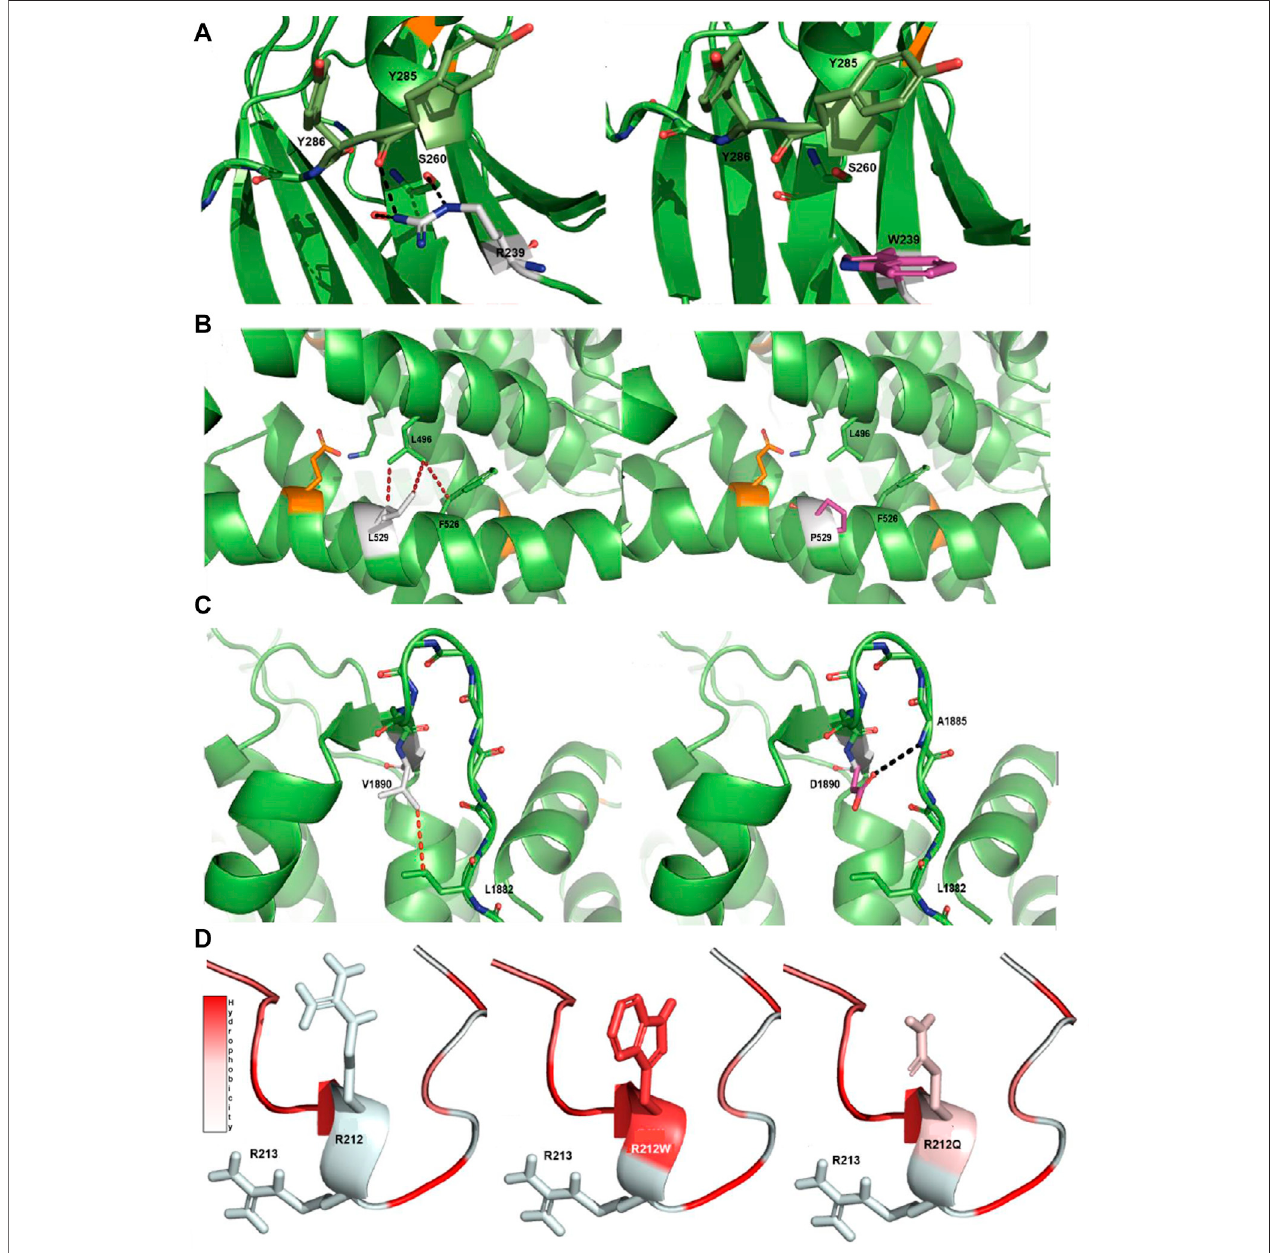
FIGURE2 | Protein modeling of variants with anotable effect on protein structure. (A) R239W VUS-high in PKC γ protein. The native R239interactswith S260and Y285 through a hydrogen bonding network. The aromatic side chain of the mutant W is unable to establish an interaction network in the same manner as the native arginine. (B) L529P VUS-high in Cav2.1 protein. The native L529 engages in a network of hydrophobic interactions with L496 and F526. The introduction of P in the middle of the helix introduces a steric clash with these hydrophobic residues and is detrimental for helix stability (Visiers et al., 2000). (C) V1890D VUS-high in Cav2.1 protein. The native V1890 interacts with L1882 through a hydrophobic interaction. The mutated D changes the conformation of the backbone of the protein, disturbing the β -sheet structure and forming a new hydrogen bond with the main chain of A1885. Native side chains are shown as white, mutated side chains as pink, known pathogenic mutations as orange, hydrophobic interactionsas red dashes and hydrogen bonds asblack dashes. (D) R212QVUS-semi high in pdyn protein. The R212Q mutation has similar hydrophobic properties to the known R212W, which is known to decrease the cleavage ef fi ciency of dynorphin, and likely functions in a similar manner. Arginine (R), tryptophan (W), serine (S), tyrosine (Y), valine (V), aspartic acid (D), leucine (L), proline (P), glutamine (Q) and phenylalanine